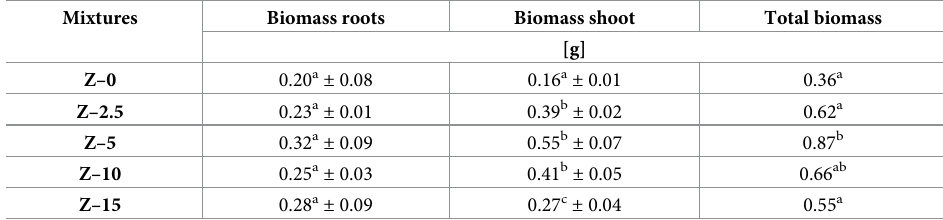
Table 7. Mean values (and the standard deviation) of red clover dry biomass obtained in the pot experiment con- ducted on soil and soil-waste